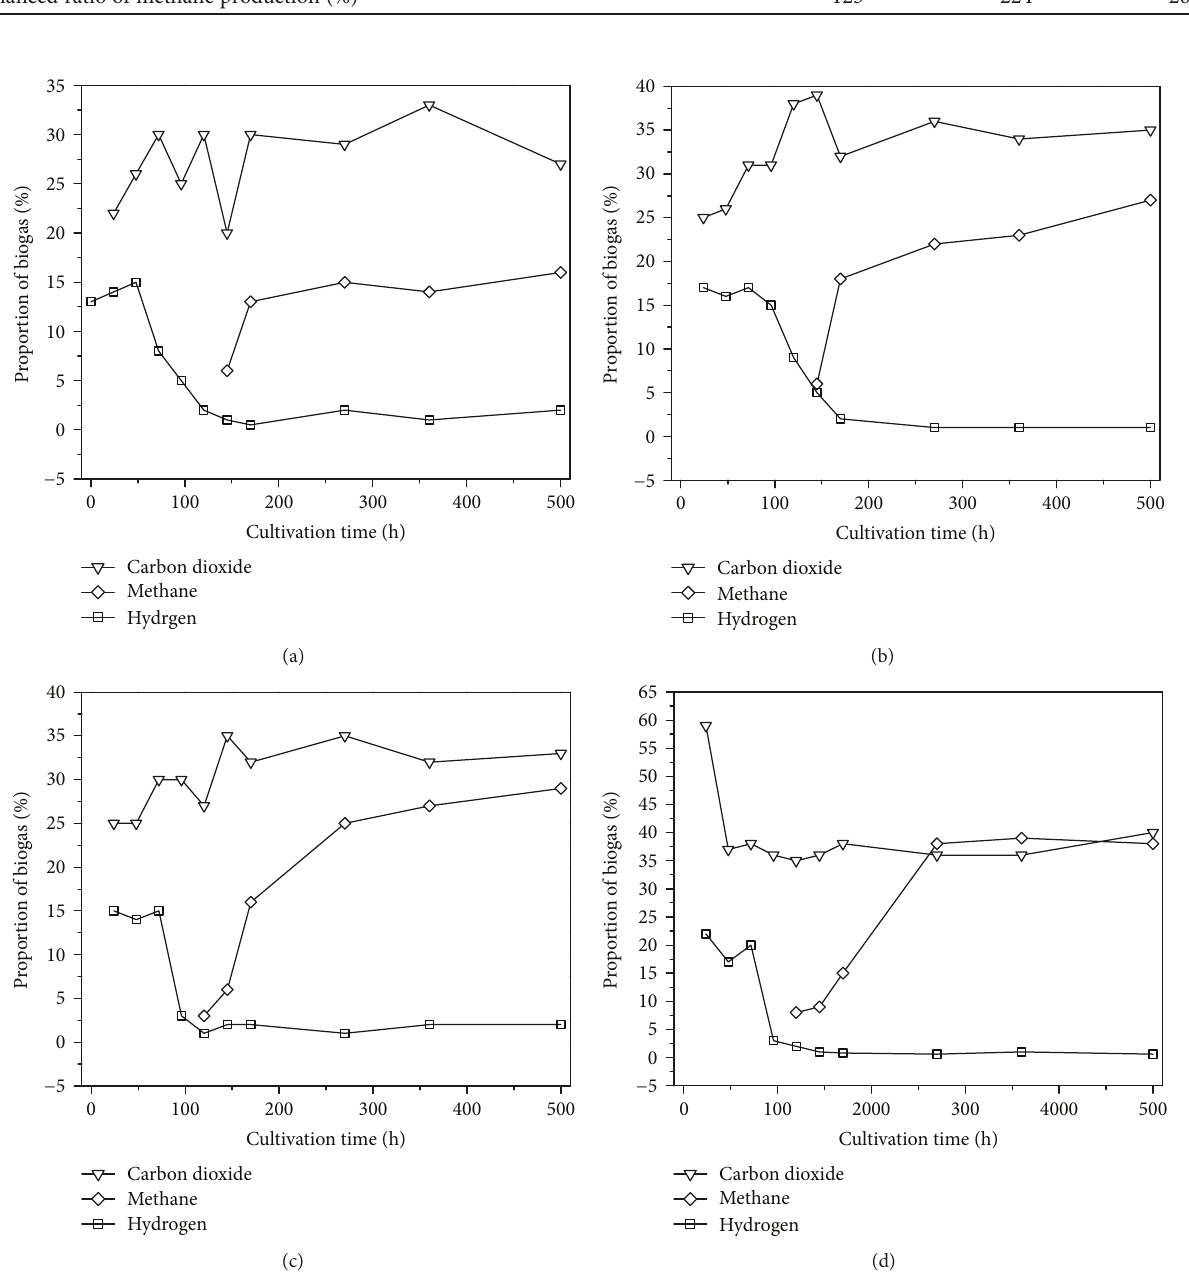
Figure 3: Biogas yields and component variation of QJ1 (a), QJ2 (b), QJ3 (c), and QJ4